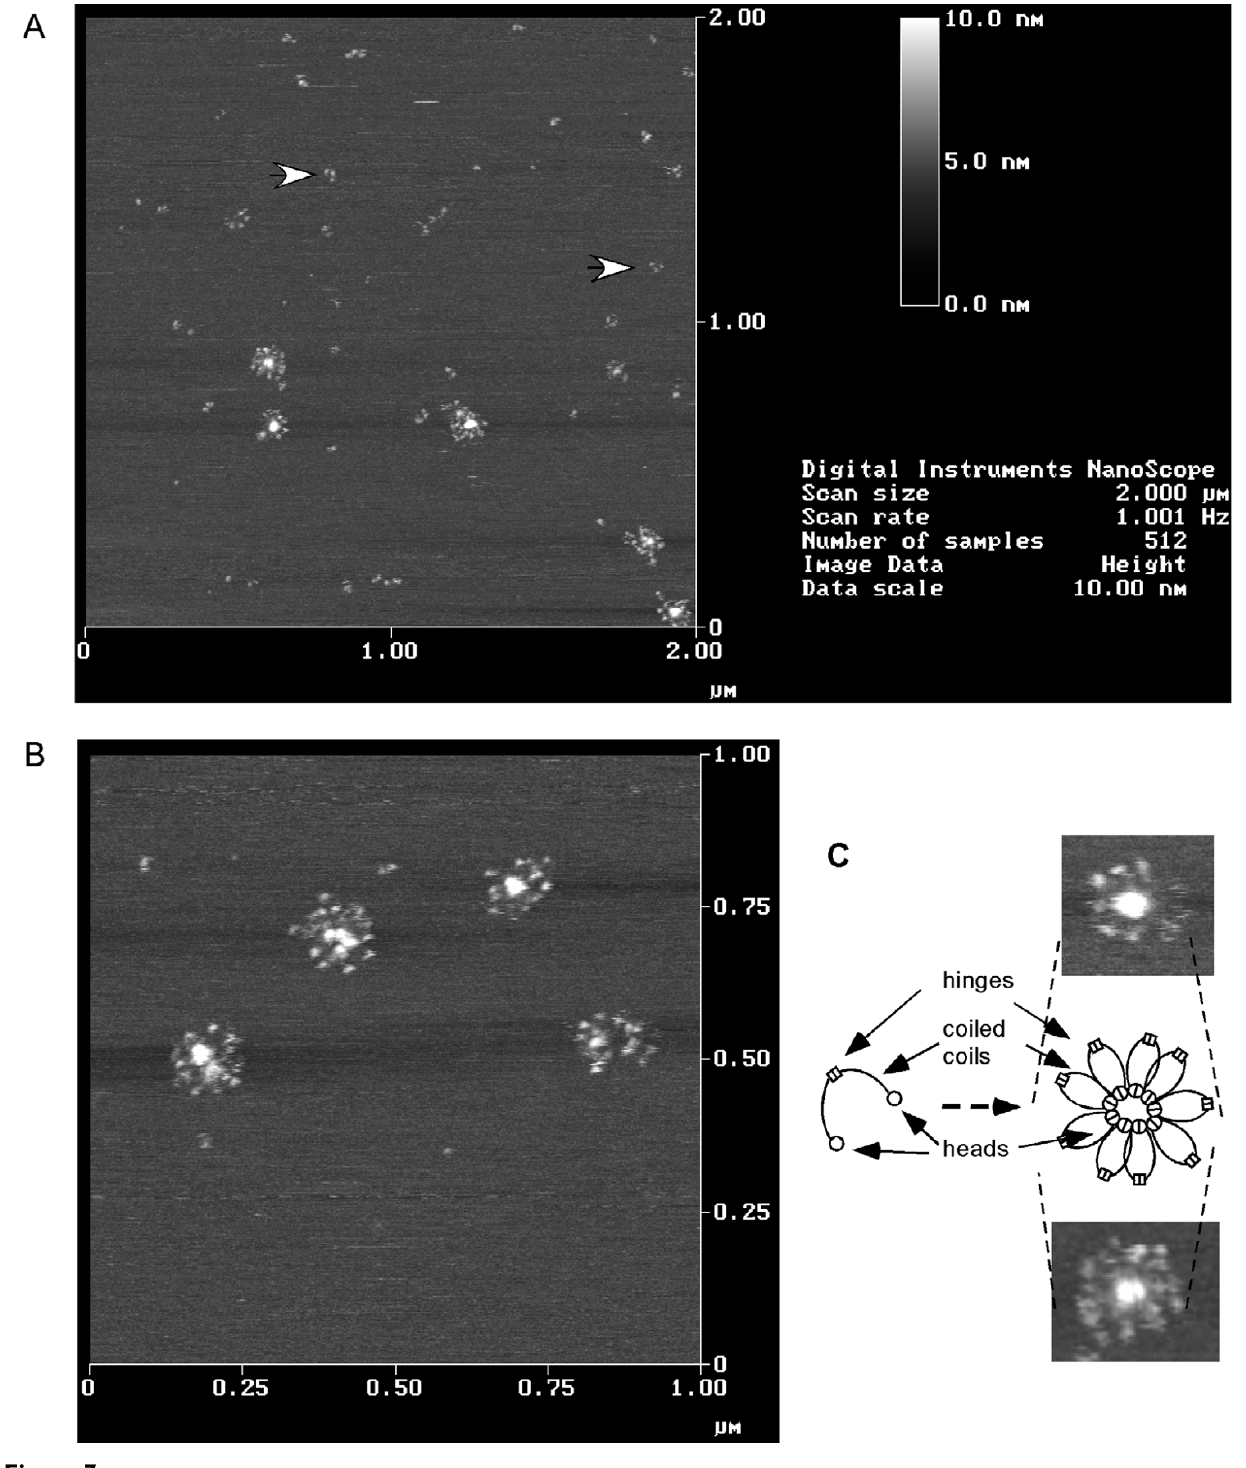
Figure 7 Atomic force microscopical image of SMC on mica in solution. Image shows raw data, just flattened by the software of the instrument. A) Typical field containing single SMC particles (indicated by arrows) and rosette like structures. B) Zoom of another field showing the rosette structures. C) Speculative model of the formation of the rosettes by SMC dimers, in which SMC head domains form the central part of the structures, and arms extend outwards, in which DNA loops could be